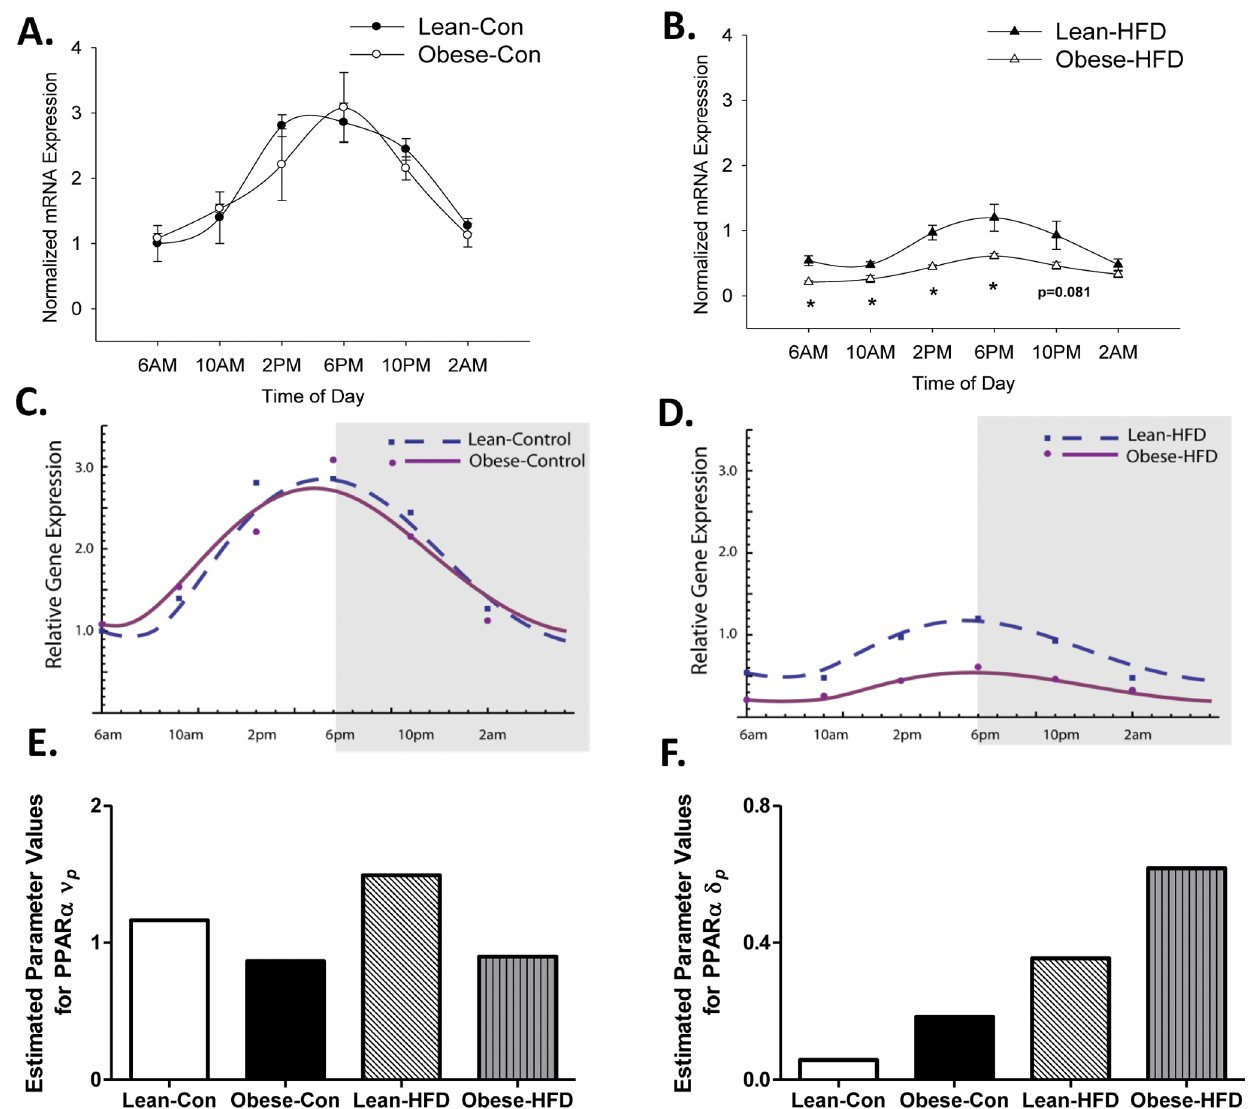
Figure 3. Circadian expression of PPAR- a mRNA. Hepatic PPAR a mRNA was assessed in lean and obese dam offspring fed A) control or B) HFD at PND35 (N=3–5 animals per group, Lean-Con 2AM and Obese-HFD 6AM (N=5 per group), Lean-Con 10AM and Obese-Con 10PM (N=3 per group), and all the remaining groups (N=4)). Statistical differences were determined using a Student’s t test. * denotes significance, P , 0.05. Mathematical model derived from relative PPAR a mRNA expression of offspring of lean and obese dams fed C) control diet or D) HFD at PND35. Model fitting incorporated eight parameters representing distinct biological mechanisms. E) Optimal values for the parameter n p which represents rates of PPAR a mRNA synthesis and F) d p which represents rates of PPAR a mRNA degradation were determined by Monte Carlo simulations (n=10,000) followed by a conjugate-gradient method implemented in Mathematica.